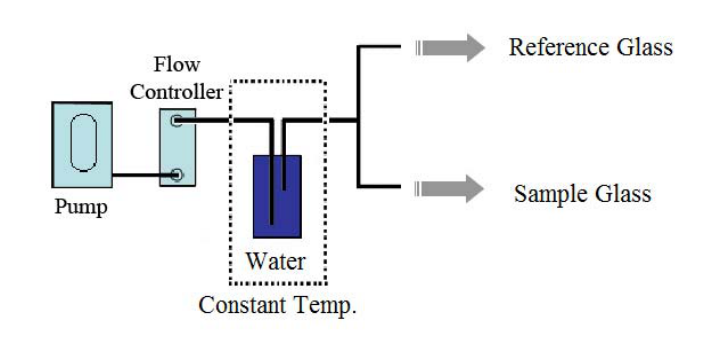
Figure 3. Schematic diagram of humidity control using hardware-based